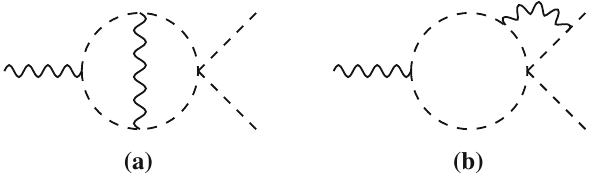
Fig. 7 Examples for Feynman diagrams in chiral perturbation the- ory, leading to nonuniversal radiative corrections. Dashed lines refer to charged pions, wiggly lines to